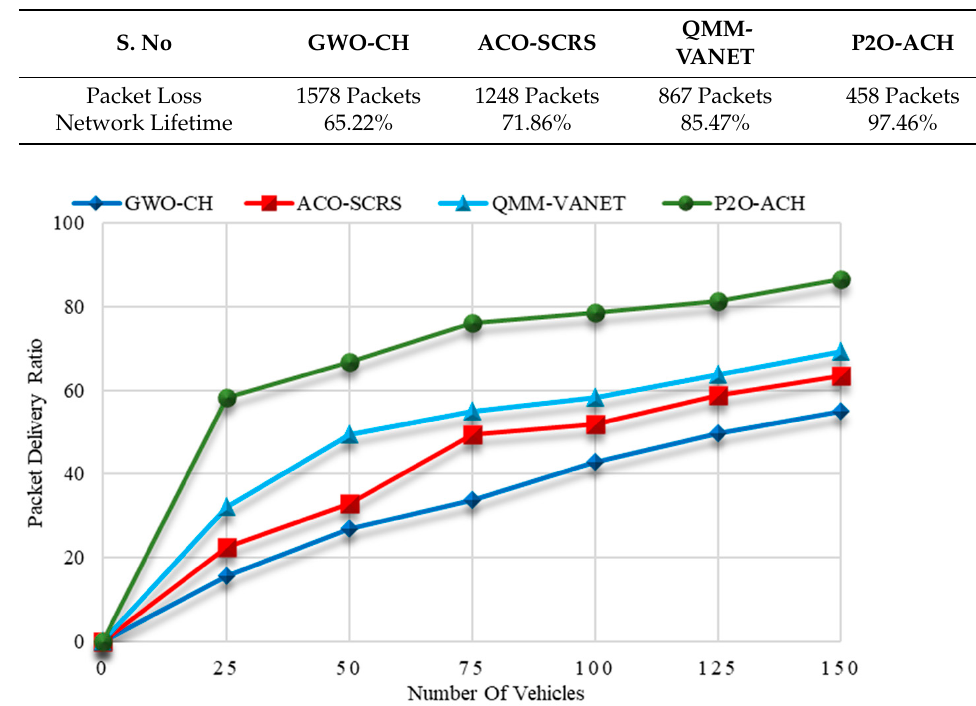
Figure 6. Packet Delivery Ratio Calculation.